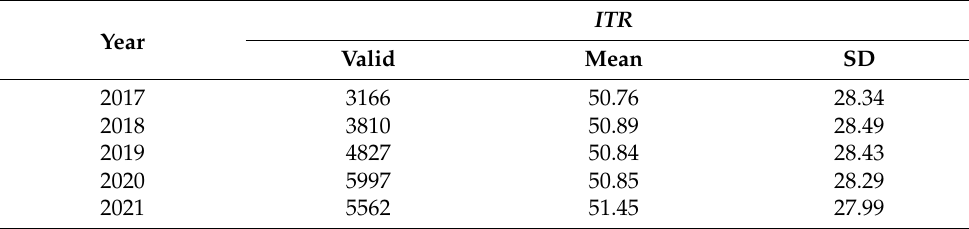
Table 2. Descriptive statistics for the ITR score by year.